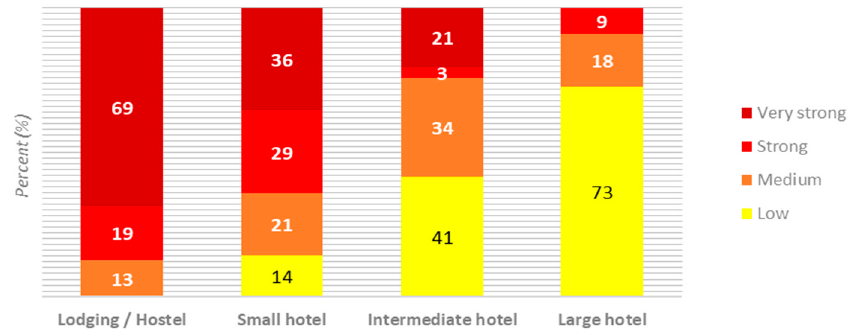
Figure 5. Distribution by vulnerability index Vi for the different accommodation types (in %).